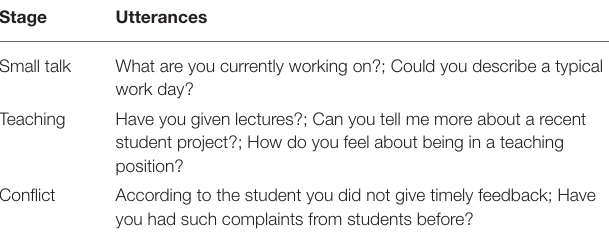
TABLE 1 | Sample utterances used in the different stages of the conversation.